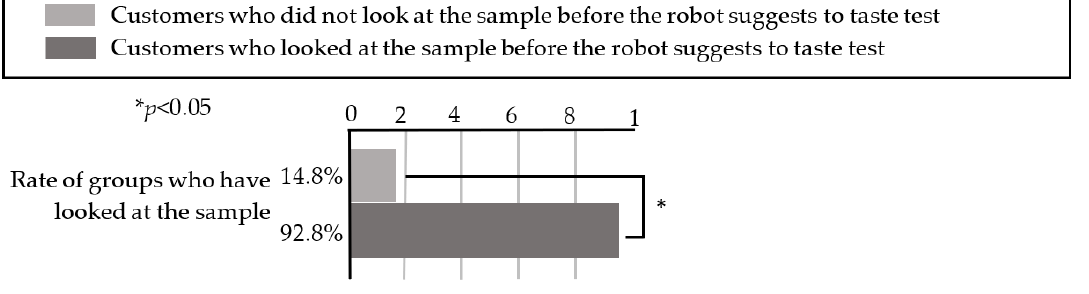
Figure 11. Rate of groups who looked at the sample after the robot suggested a tasting.